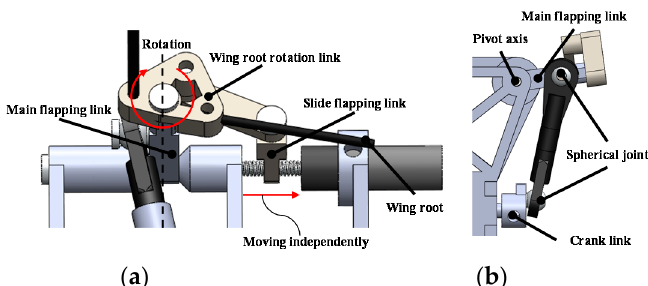
Figure 12. ( a ) Side view of the prototype design for the rotation mechanism; ( b ) front view of prototype design for the flapping mechanism.